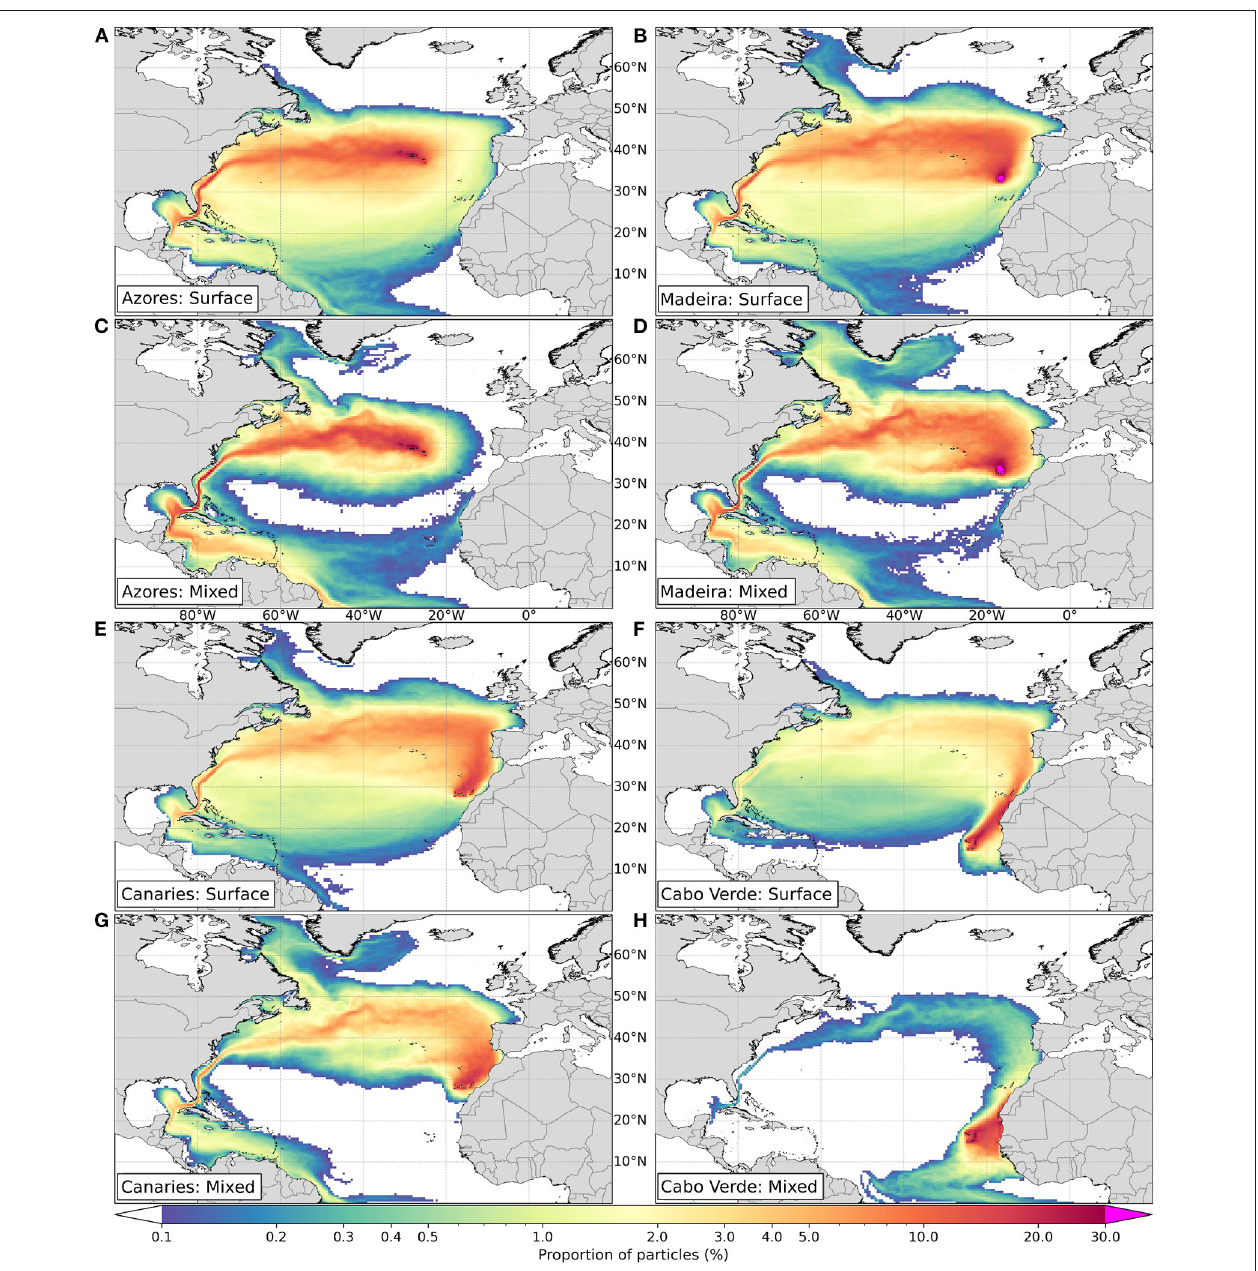
FIGURE 4 | Proportion of B surface (A,B,E,F) and B mixed (C,D,G,H) particles detected in 0.5 ◦ grid cells. Color map is in logarithmic scale, in which cells with < 0.1 % are